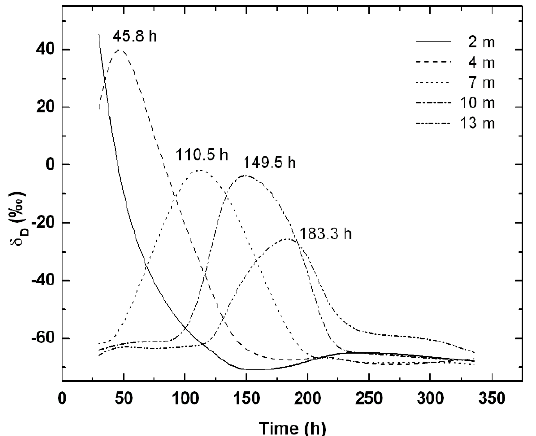
Figure 3. Deuterated water flow movement in the constructed wetland